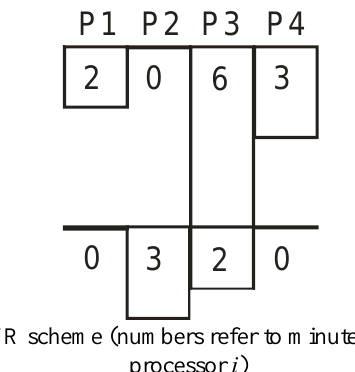
Fig. 6. SATR scheme (numbers refer to minutes, P i refers to processor i )